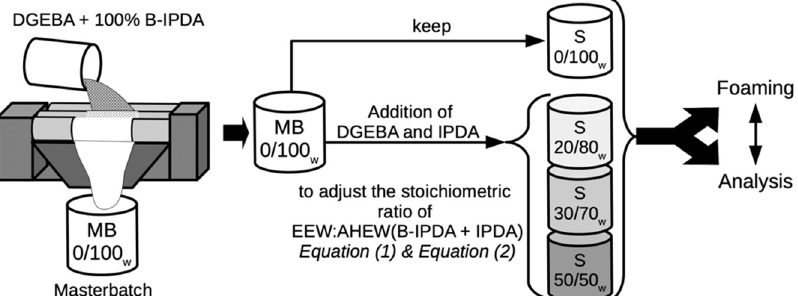
Figure 2. Workflow of sample preparation starting with masterbatch (MB) processing and further addition of DGEBA and IPDA in required amounts to meet new stoichiometric ratios with the desired blend systems of IPDA and B-IPDA, which were finally foamed and analyzed.